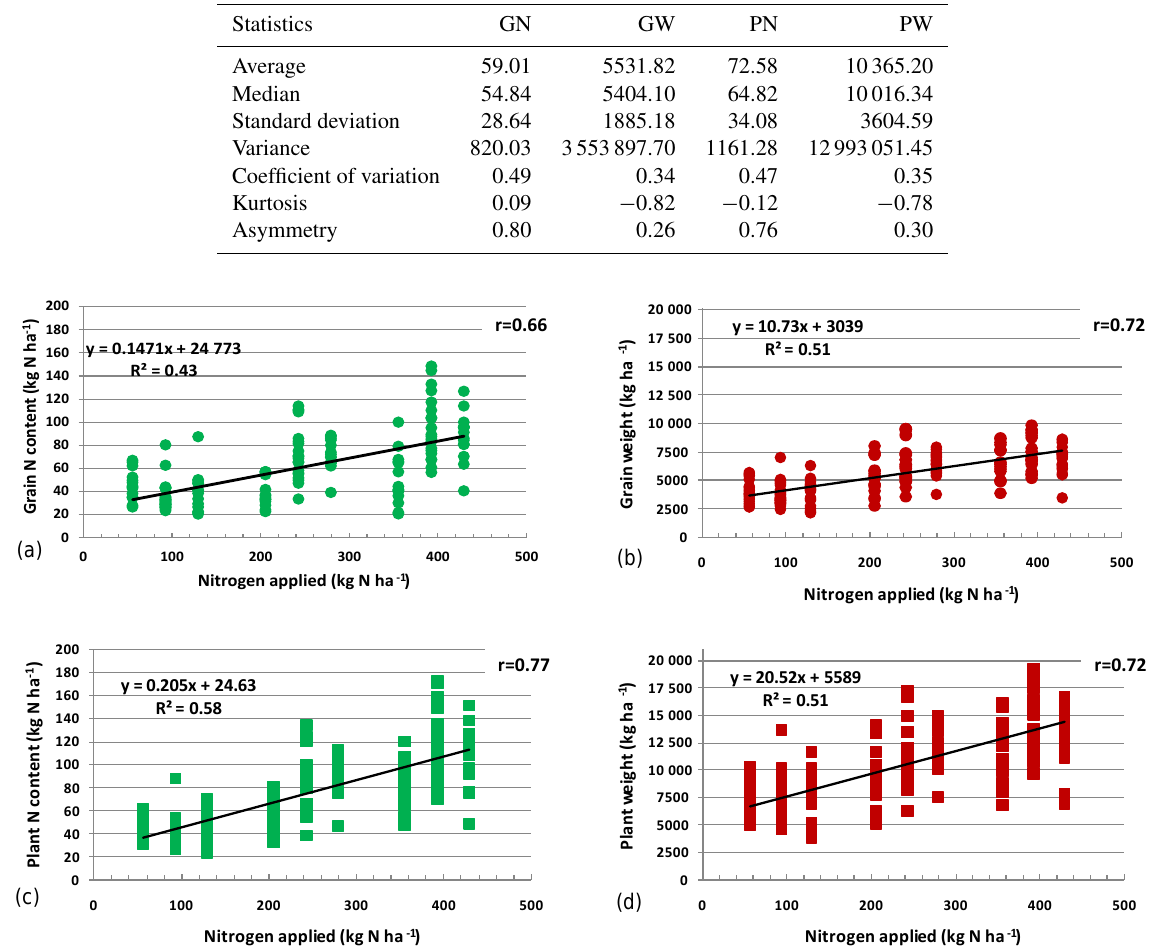
Figure 4. Correlations with nitrogen applied (N app ) of each variable: (a) grain nitrogen content (GN), (b) grain weight (GW), (c) wheat nitrogen content (PN) and (d) wheat weight